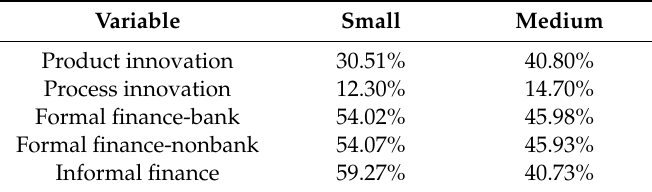
Table 1. Frequency of innovation and financial capital for all countries.